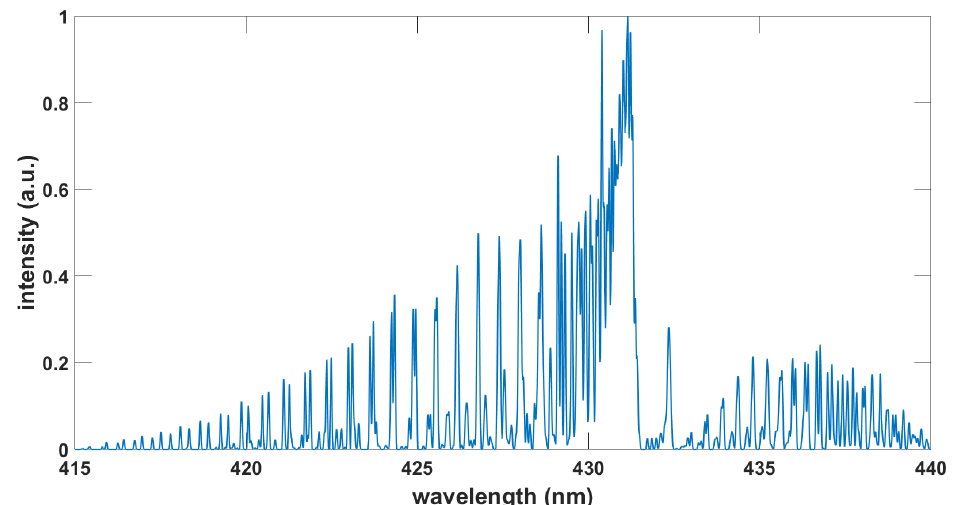
Figure 1. Computed CH A − X spectrum, ∆ v = 0, δ λ = 0.05nm, T = 3.0 kK.